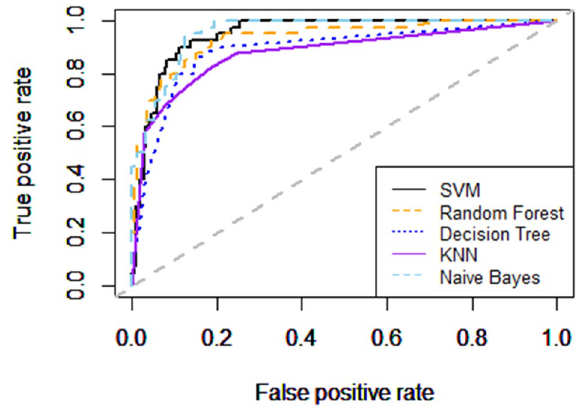
Figure 7. The AUROC values of five different machine learning models. Analysis was conducted in R (R Core Team 2014) and figures were produced using the package ROCR 35